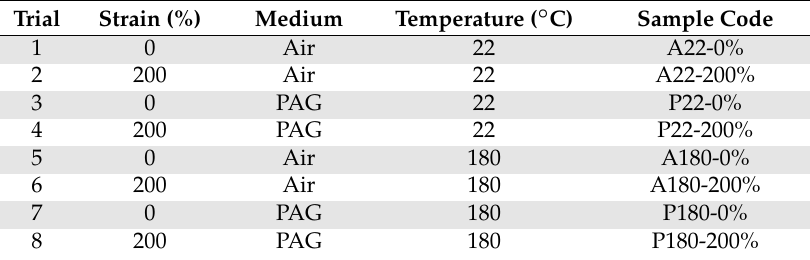
Table 2. The 2 3 full factorial experimental layout and the sample codes.